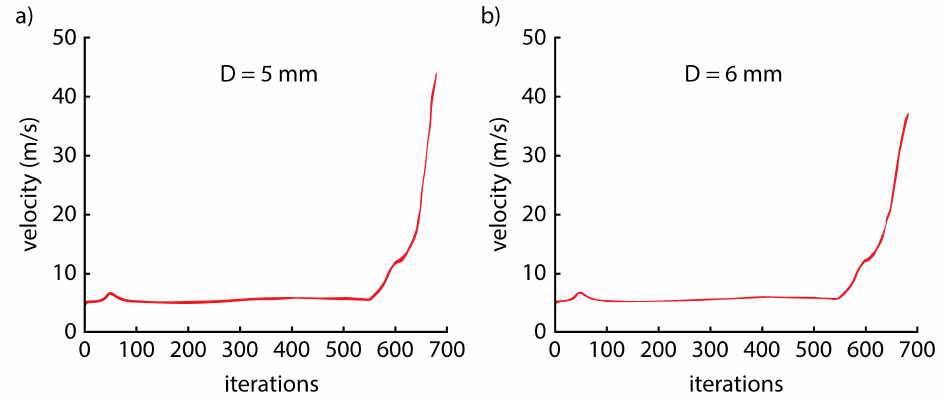
Figure 12. Velocity distributions with 7 openings each of which has a diameter of 6 mm ( b ) and 10 openings each of which has a diameter of 5 mm ( a ) in Solidworks Flow Simulation.